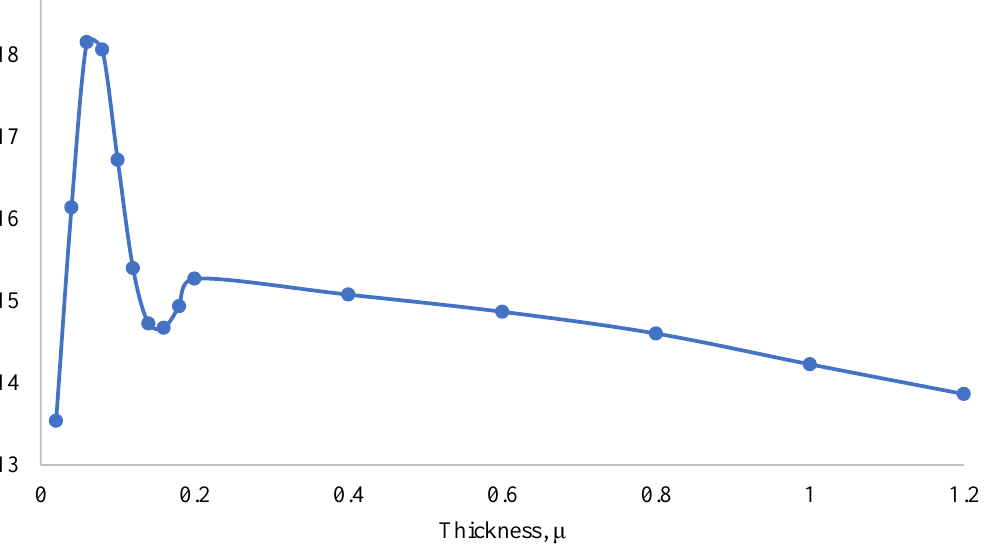
Figure 9. Dependence of the short-circuit current of the MoO 3 /Si heterojunction solar cell on the thickness of the MoO 3 layer. current increased by 0.6 mA/cm 2 . When the thickness increased from 200 nm to 1200